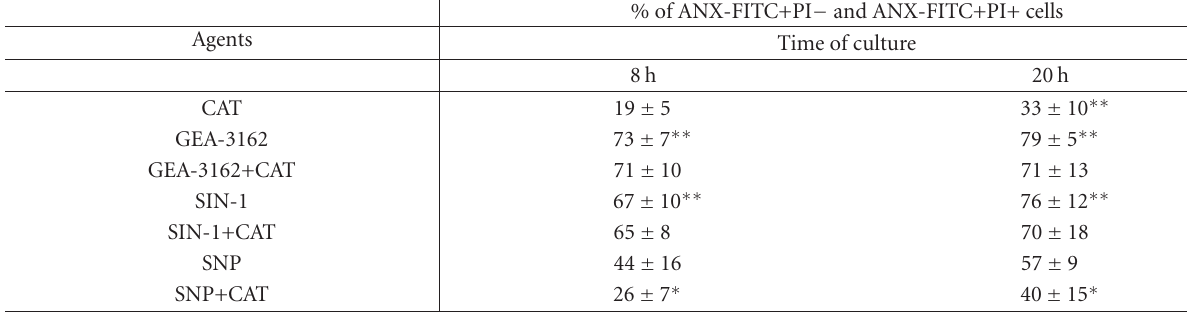
Table 3. E ff ect of exogenous catalase (CAT) on apoptosis of neutrophils nontreated and treated by NO donors in vitro, measured by ANX-FITC and PI binding. Neutrophils (1 × 10 6 cells) were incubated with the indicated stimuli in the presence of CAT (1200 U/mL) or not for 8 and 20hours and apoptosis was determined as described in “materials and methods.” Results are given as means and SD percentages of the sum of cells binding ANX-FITC+PI − and ANX-FITC+PI+ for 6 separate experiments. Statistical significance: ∗∗ denotes neutrophils with CAT versus neutrophils with NO donors, ∗ denotes neutrophils with SNP versus neutrophils with SNP+CAT ( P ≤ .